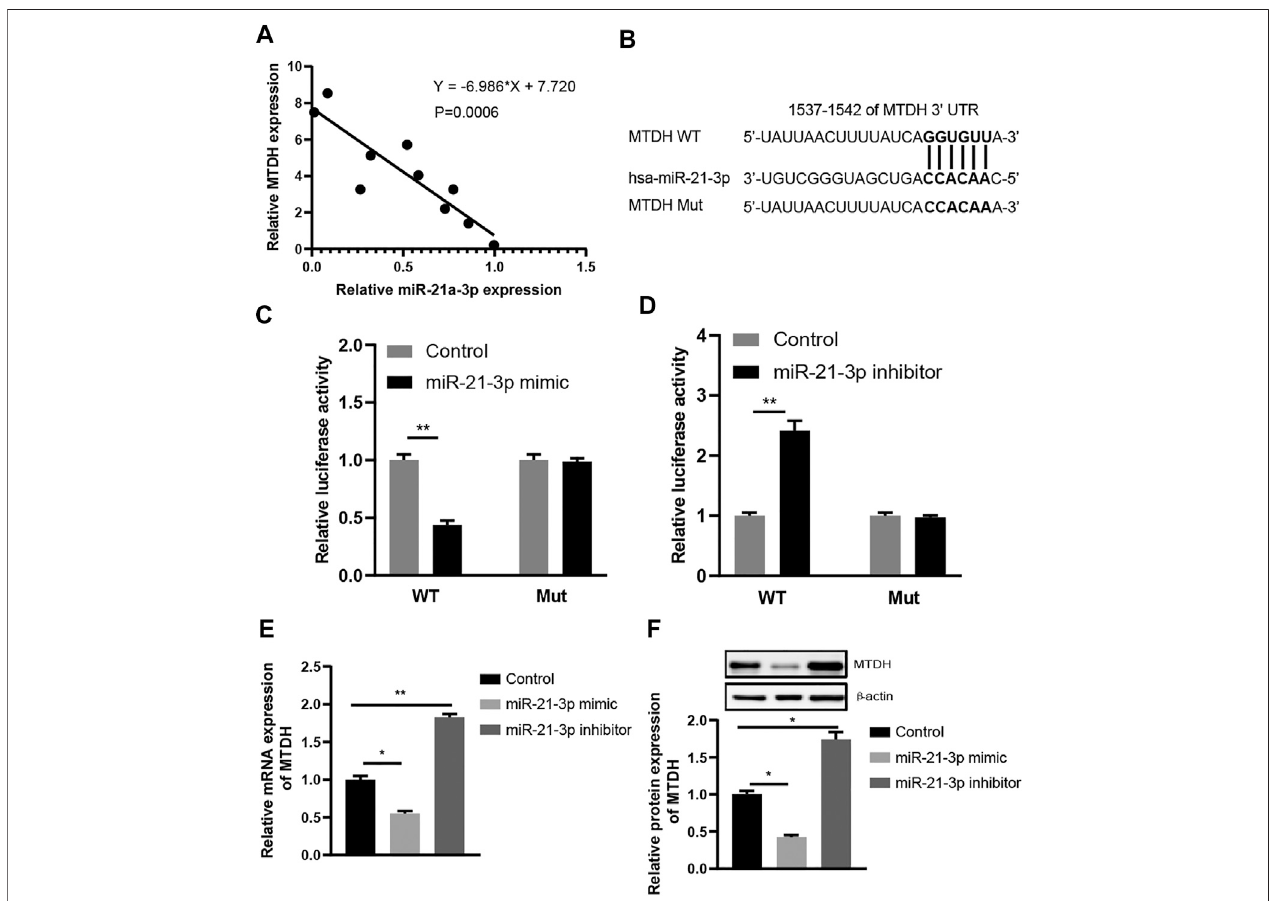
FIGURE3 | MTDH isa direct target geneof miR-21-3p. (A) Spearmanrank correlation between miR-21-3p and MTDH levels in CRC tissues ( n (cid:2) 10) byRT-qPCR analysis.miR-21-3pexpressionwasnormalizedtoU6,andMTDHexpressionwasnormalizedtoGAPDH.TheanalysisresultsindicatedthatmiR-21-3pexpressionwas inverselyrelatedtoMTDH. (B) SchematicrepresentationofthepredictedmiR-21-3pbindingsequenceinthe3 ′ -UTRofMTDHwithwild-typeformandwithmutantform. (C) Results of luciferase reporter assays in Caco-2 cells, with co-transfection of WT or Mut 3 ′ -UTR and miR-21-3p mimic, as indicated. (D) Results of luciferase reporter assays in Caco-2 cells, with co-transfection of WT or Mut 3 ′ -UTR and miR-21-3p inhibitor, as indicated. (E) mRNA expression of MTDH in Caco-2 cells transfectedwithmiR-21-3pmimicorinhibitor.OverexpressionofmiR-21-3presultedinstrikingreductionofMTDHatthemRNAlevel. (F) ProteinexpressionofMTDHin Caco-2cellstransfectedwithmiR-21-3pmimicorinhibitor.OverexpressionofmiR-21-3presultedinstrikingreductionofMTDHattheproteinlevel.* p < 0.05,** p < 0.01.